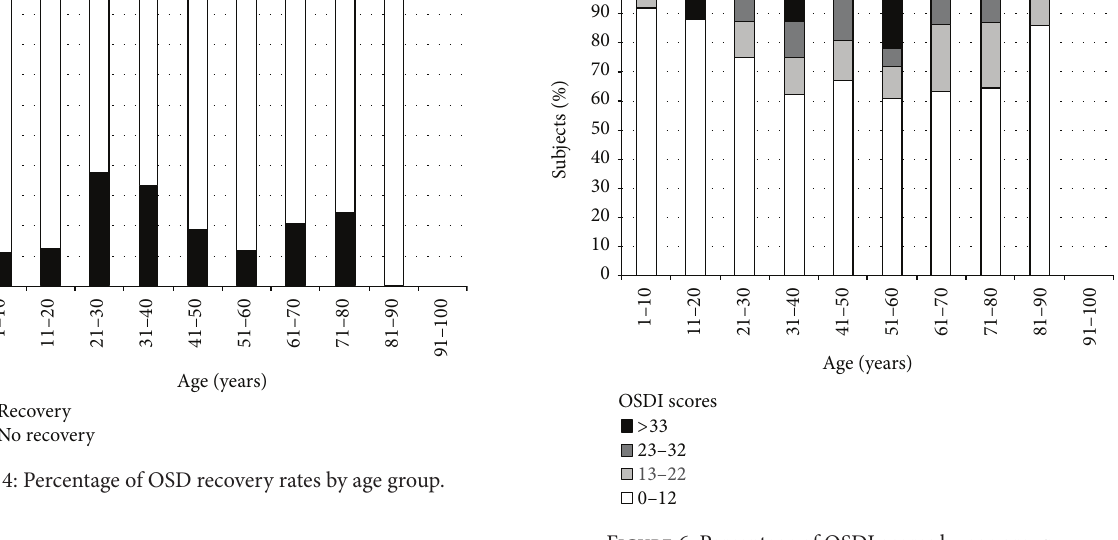
Figure 6: Percentage of OSDI scores by age group.